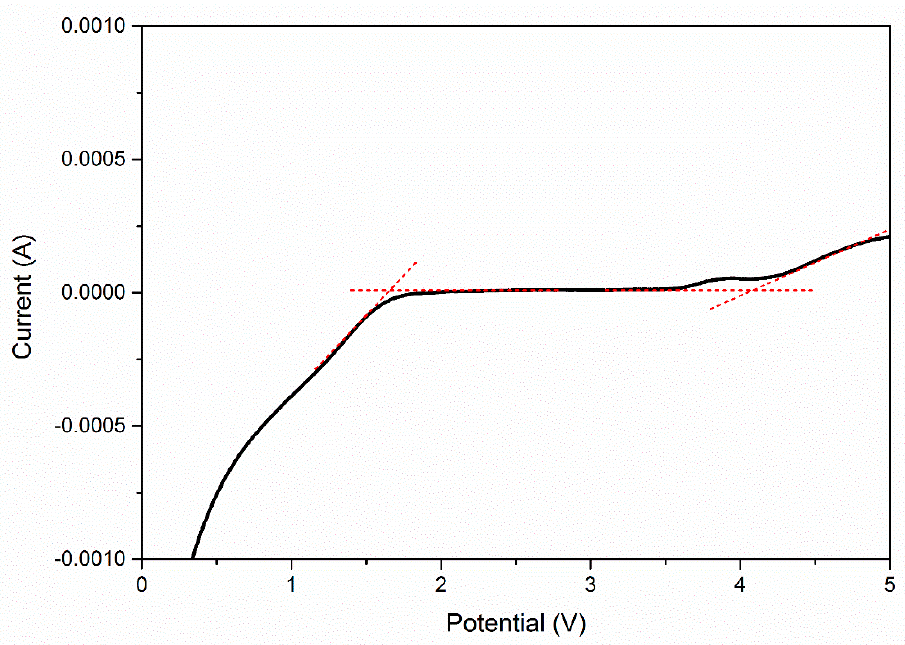
Figure 6. Linear Sweep Voltammetry of PUA/LiClO 4 /EC (9 wt. %) electrolyte.